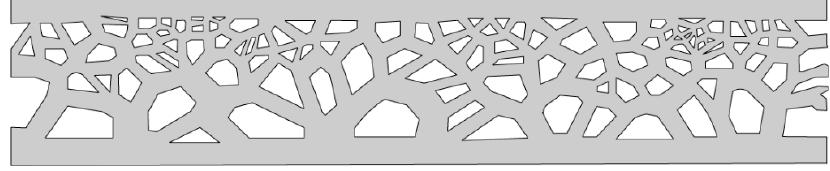
Figure 38. The theoretical model of constant support